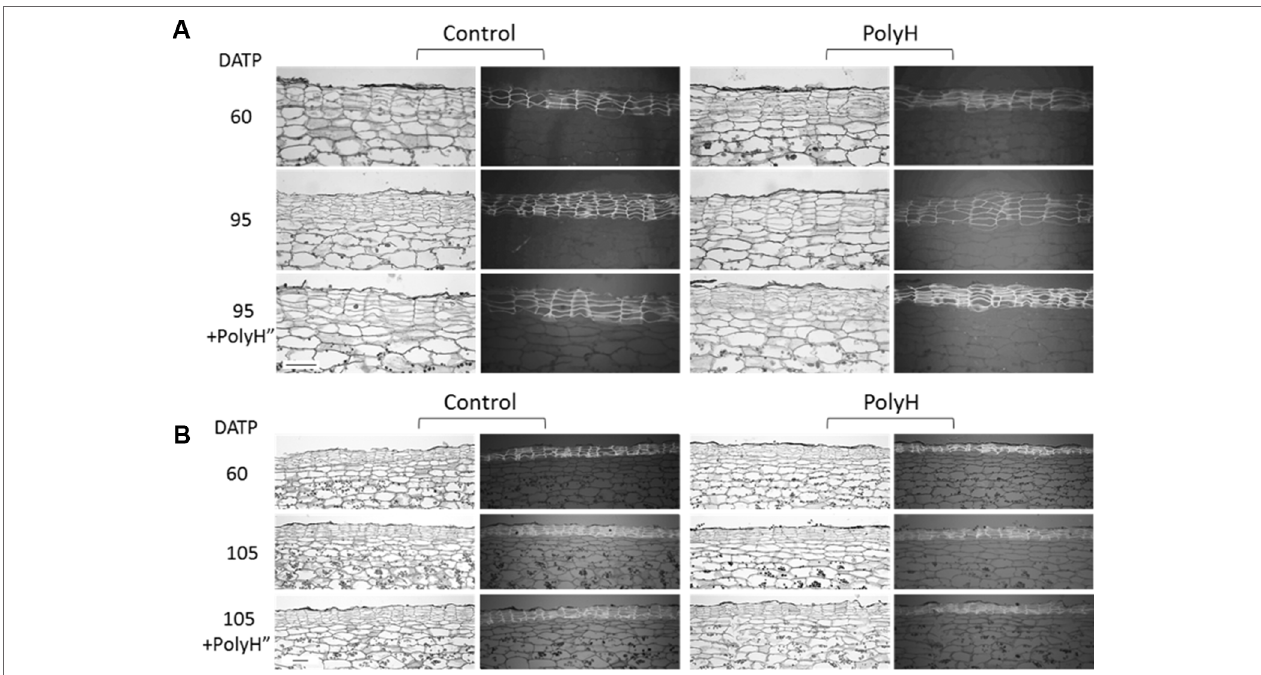
FIgURE 9 | Anatomical study of tuber skin of potato cvs. Rosanna (a) and Vivaldi (B) (experiment 3). Sample labeling and treatments are as described in Figures 5 and 6 . Sections were taken from three independent tubers for each treatment and developmental stage, and one representative section is shown. Each section is represented by two frames: the left shows tissue morphology under a light microscope, the right shows the autofluorescence of skin cells on a dark gray background as seen by UV microscope. Note that the morphology of the potato skin is characterized by cell column arrangements. Bar = 100 µm.